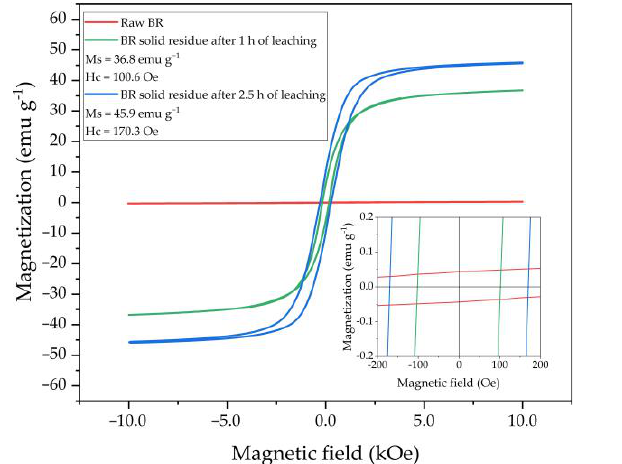
Figure 11. Magnetization curves for the BR and the BR solid residues obtained after BR leaching at 110 °C, C Na2O 360 g L −1 for 1 h and 2.5 h ( a ) and the sands and sand solid residues obtained after BR leaching at 110 °C, C Na2O 360 g L −1 for 1 h and 2.5 h ( b ).